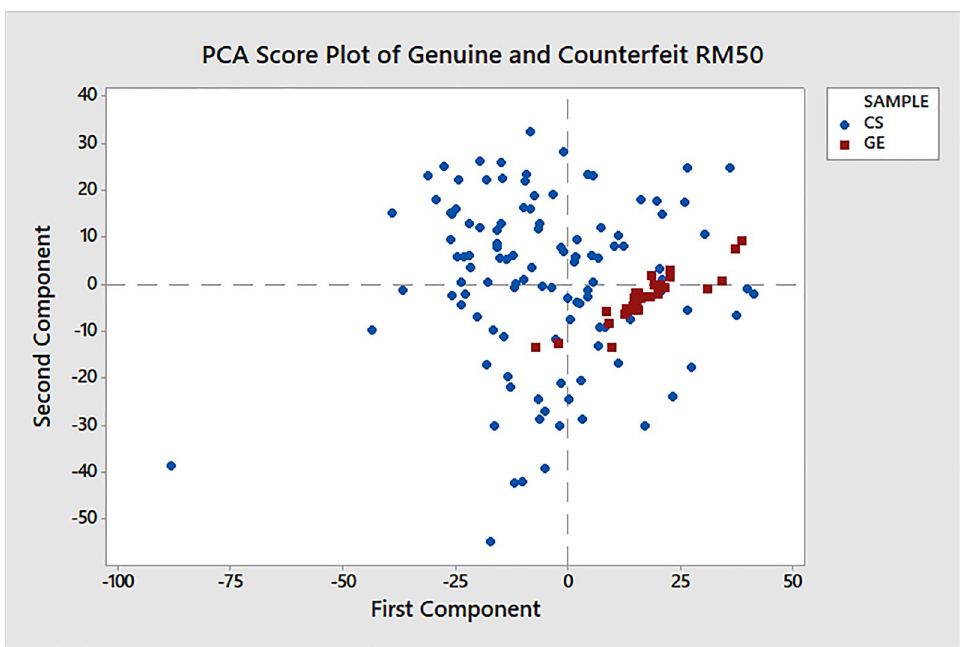
Figure 14. The PCA Score Plot of Genuine (GE) and Counterfeit (CS) RM50 Samples. This figure was generated using Minitab version 17 (Minitab Inc., PA, USA; https:// www. minit ab.